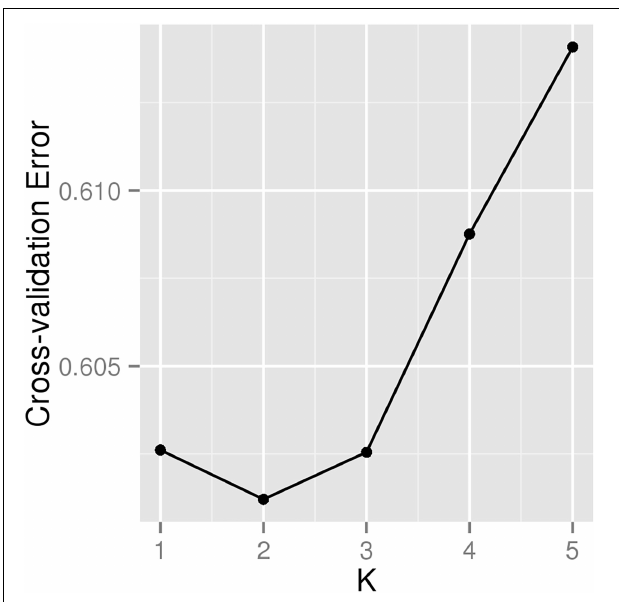
FIGURE 1 | Cross-validation plot for determining the best K.